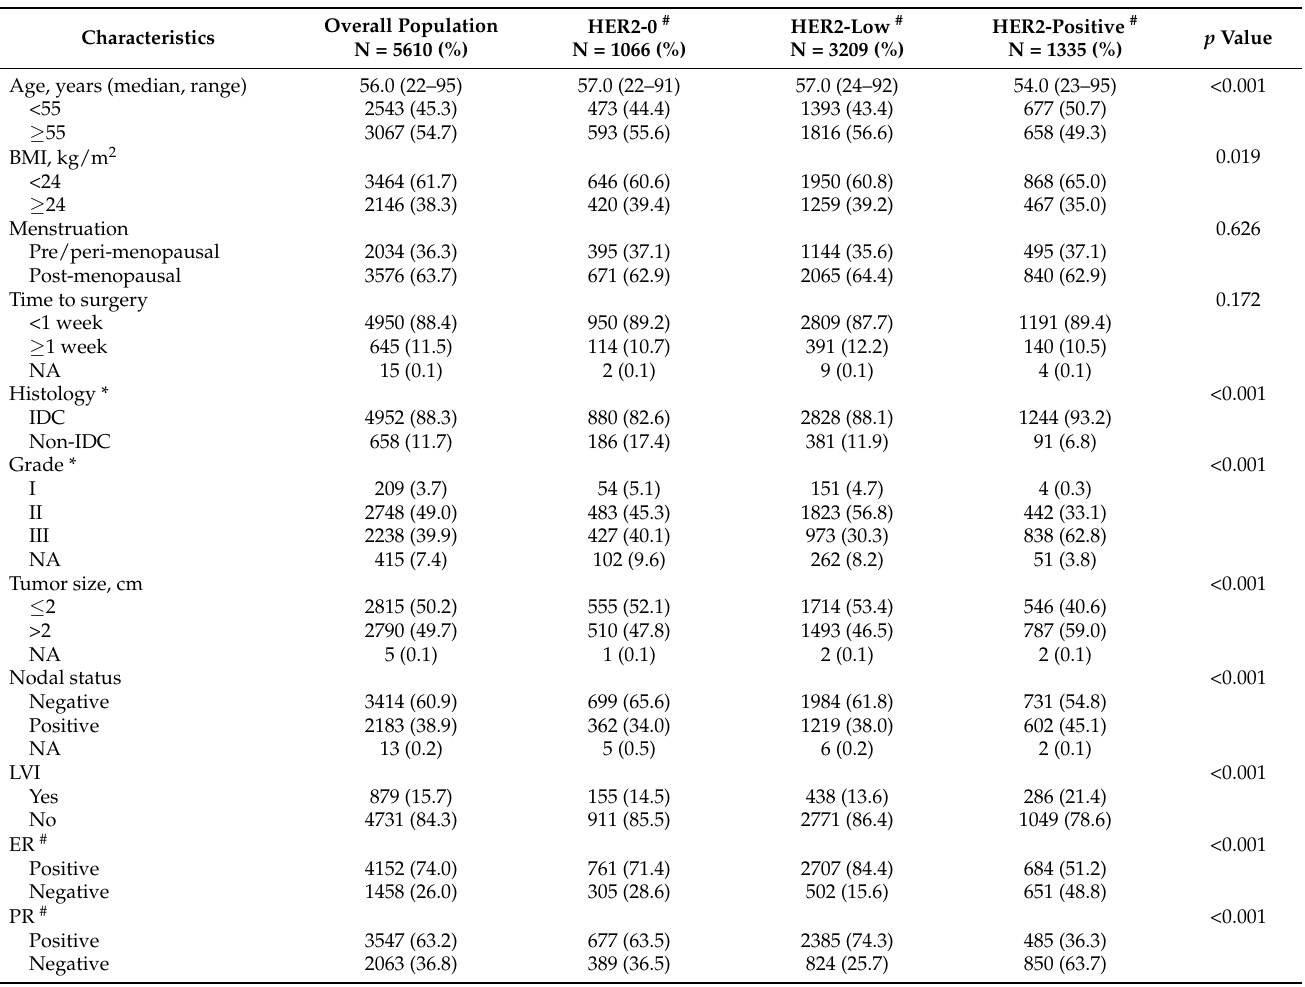
Table 1. Baseline clinicopathological features of